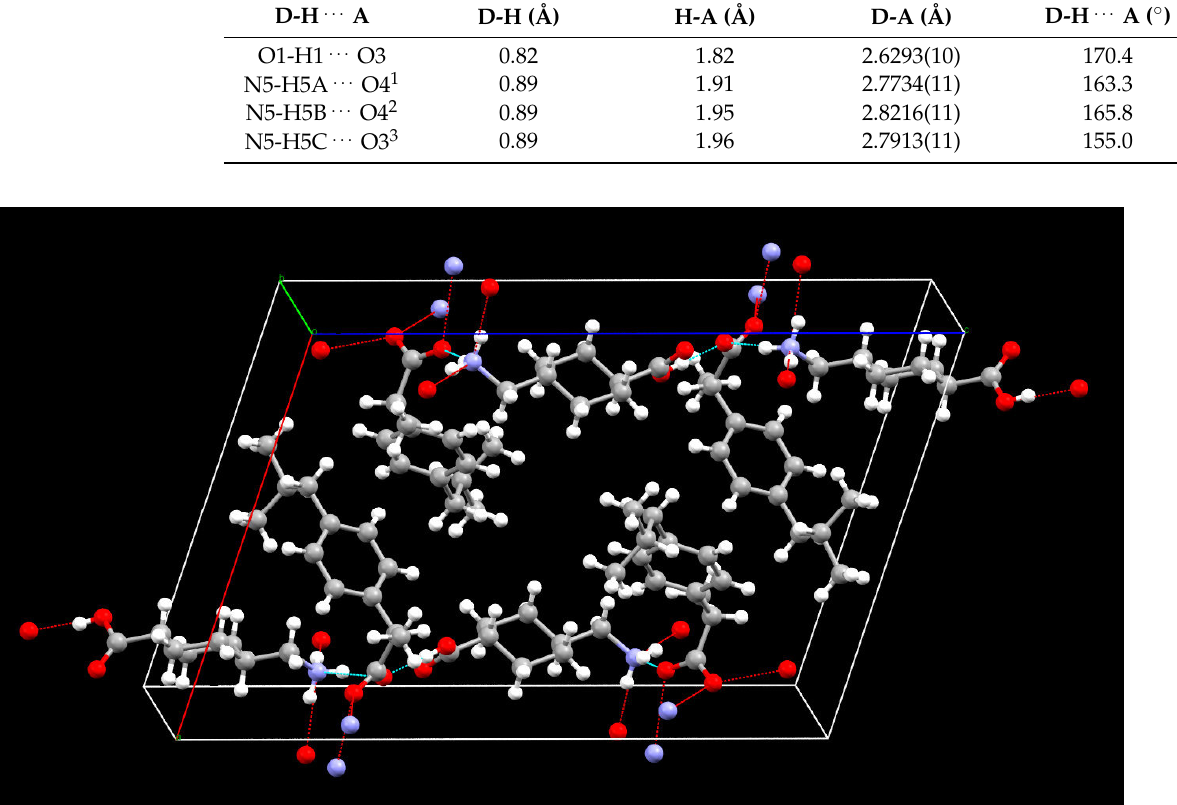
Figure 8. Packing diagram of the IBP–TXA salt (red: oxygen, blue: nitrogen, grey: carbon, white: hydrogen).